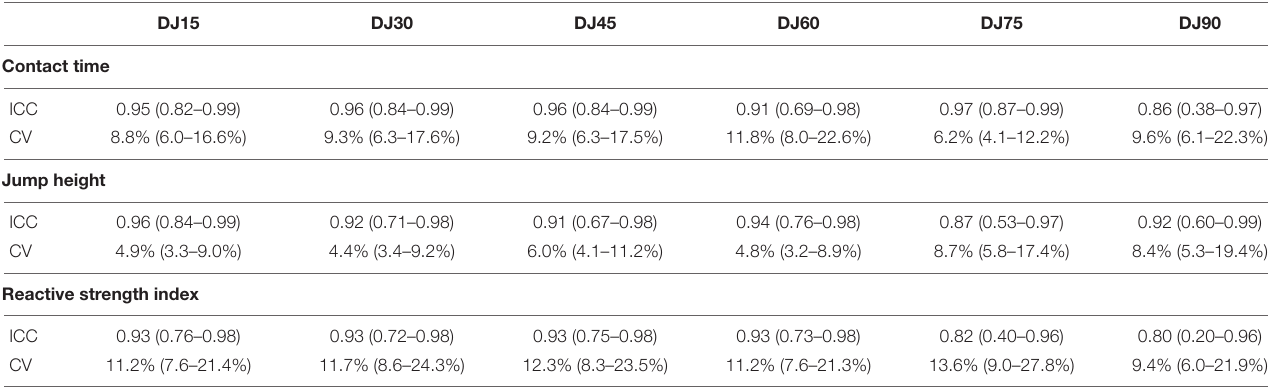
TABLE 1 | Reliability [intra-class correlation coefficient (ICC) and coefficient of variation (CV)] of drop jump performance variables. 1